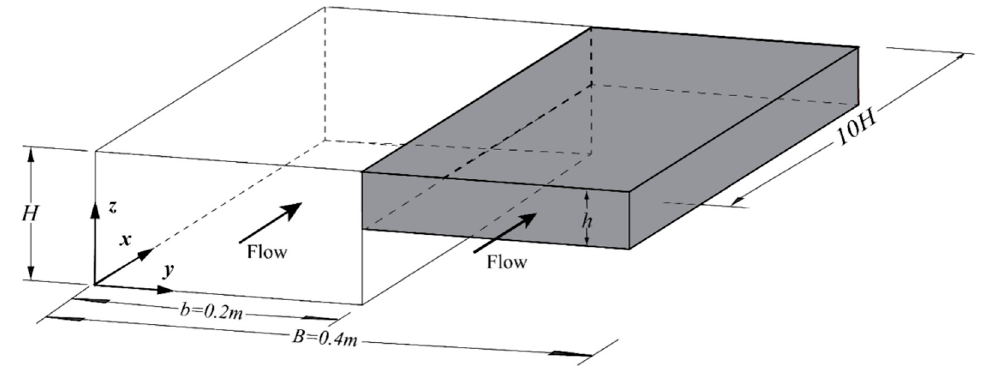
Figure 6. Schematic diagram of the compound open channel flows with floodplain vegetation.